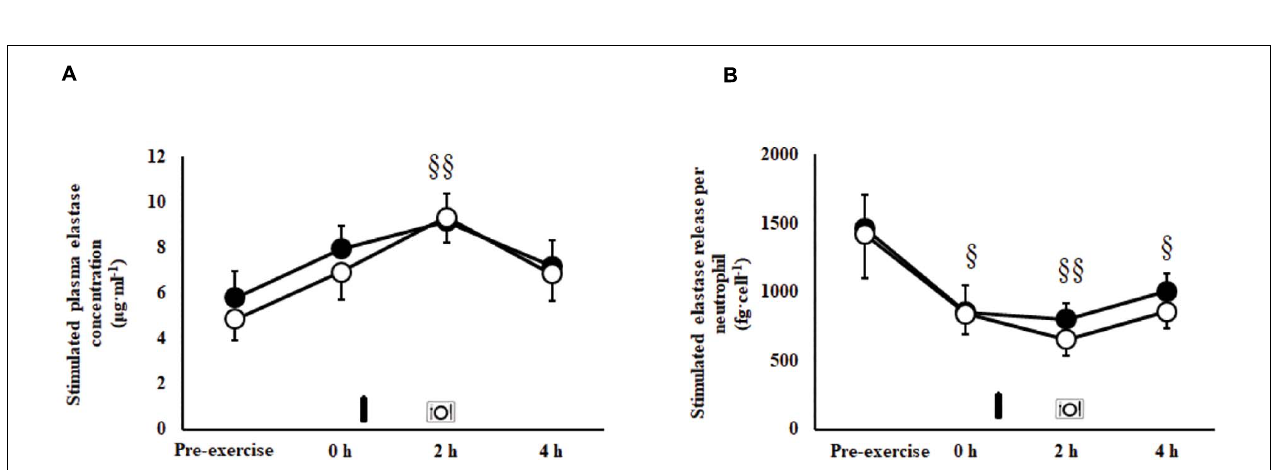
FIGURE 4 | Total (A) and per cell (B) bacterially-stimulated neutrophil elastase release after 2 h HIIT exercise in temperate ambient conditions and consumption of a chocolate dairy milk (CM: (cid:4) ) or the carbohydrate-electrolyte (CEB: ◦ ) recovery beverage. Mean ± SEM ( n = 14): MEOTime §§ P < 0.01 and § P < 0.05 vs.